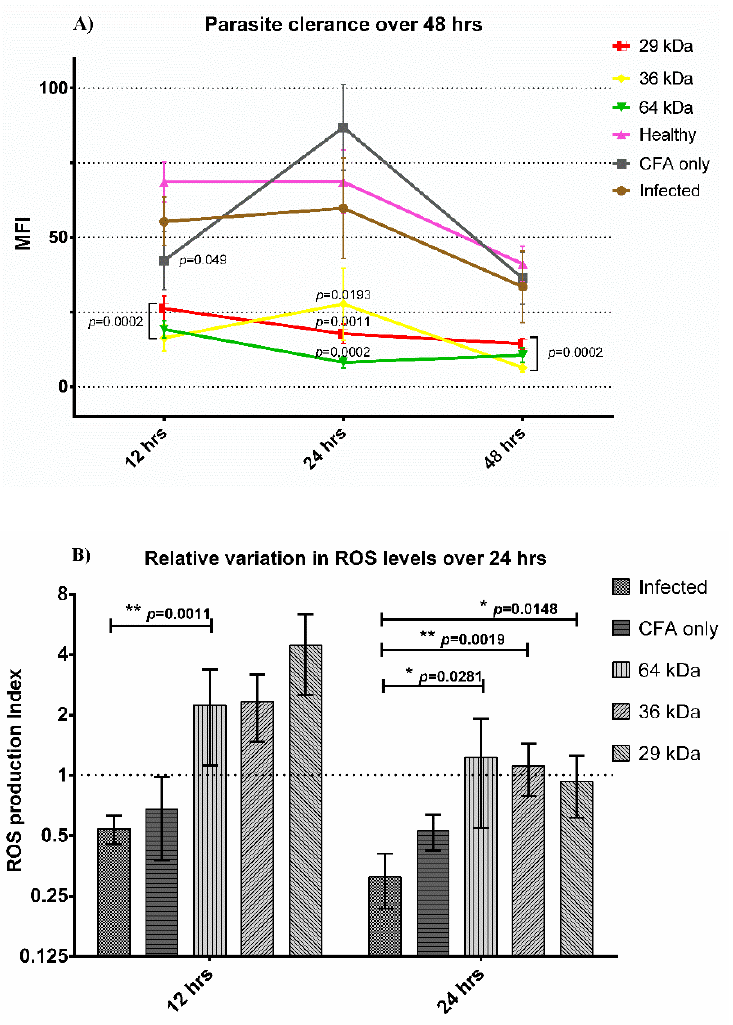
Figure 4. ( A ) Parasite clearance observed at different time intervals. Statistical comparison between healthy and test groups. Average MFI (mean fluorescent intensity) at different time points from adherent peritoneal cells of different animal groups. ( B ) Variation in ROS production levels over 24 h. ROS is expressed relative to healthy control, ROS production index (RPI) = MFI test group/MFI healthy group. The dashed line indicates the expression levels of healthy cells. CFA: Freund’s adjuvant. n = 8, mean values ± SEM. ( A ) Statistical comparison of Student’s t -test between the test group and healthy group. Level of significance, ns p > 0.05, * p ≤ 0.05, ** p ≤ 0.01.